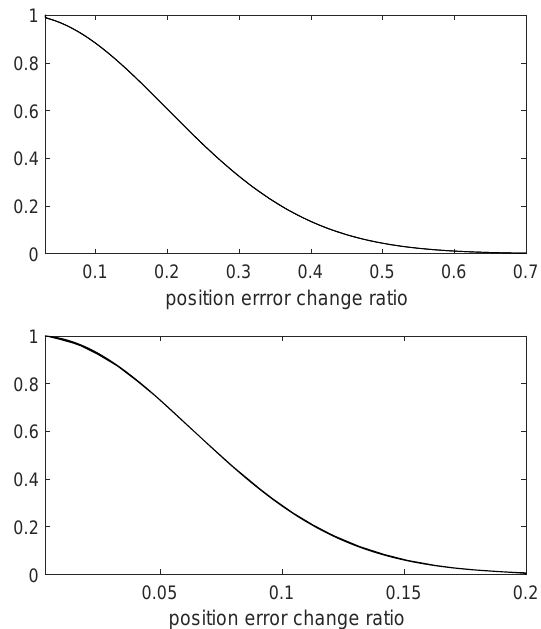
Figure 9. Curve with smoothing function.